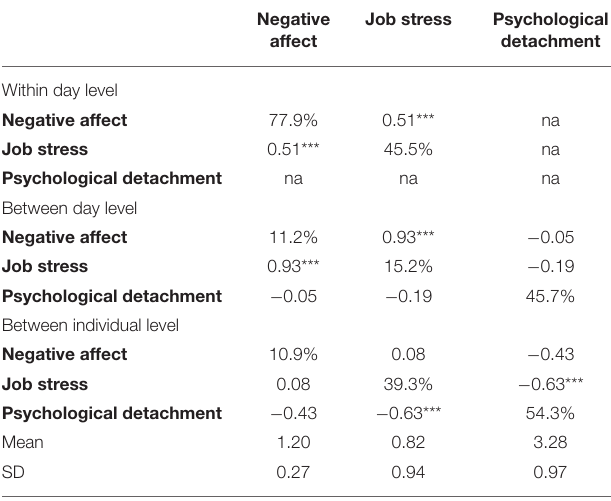
TABLE 1 | Percentages of variation and correlations on three levels, means and standard deviations for negative affect, job stress and psychological